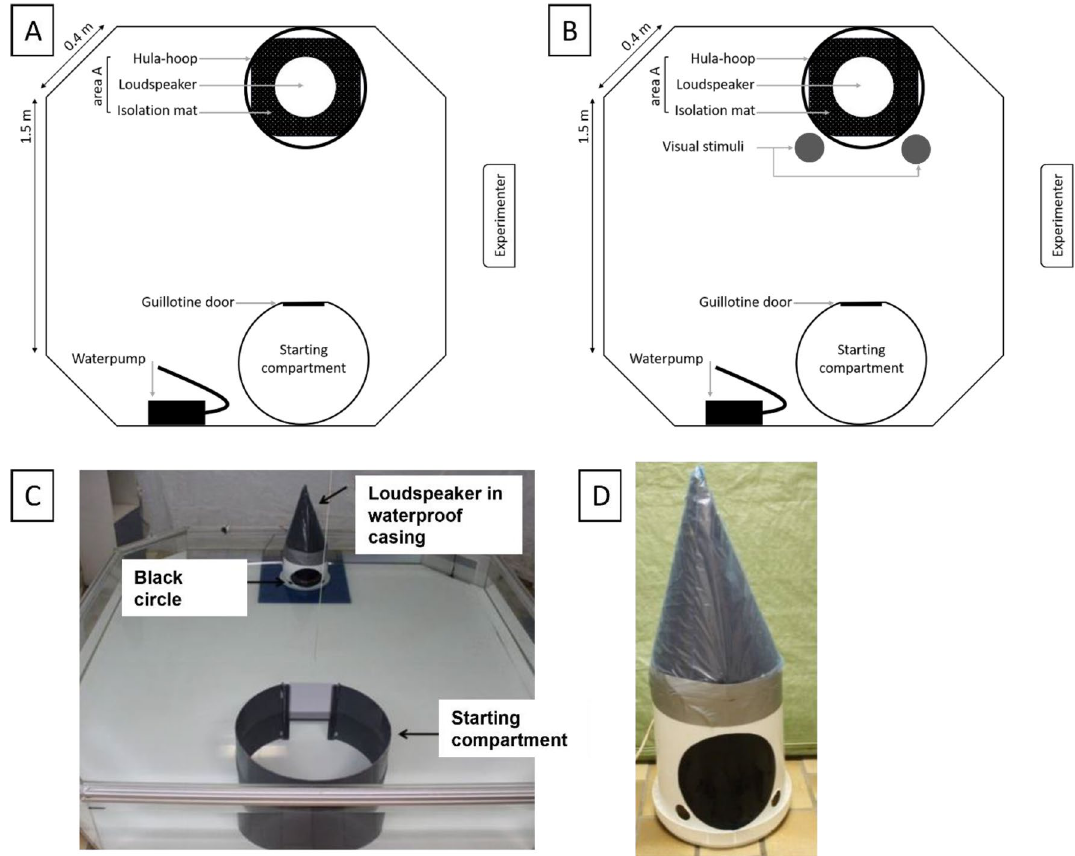
Figure 1. Schematic overview of experimental set-up for ‘Go/No-Go’ experiments (not to scale). ( A ) ’No-Go’- trial (visual stimulus absent). ( B ) ‘Go’-trial (visual stimuli present for Group 2). ( C ) Side view of experimental setting. Note that the water pump was taken out for this picture. ( D ) Loudspeaker built into waterproof casing with a black circle on the